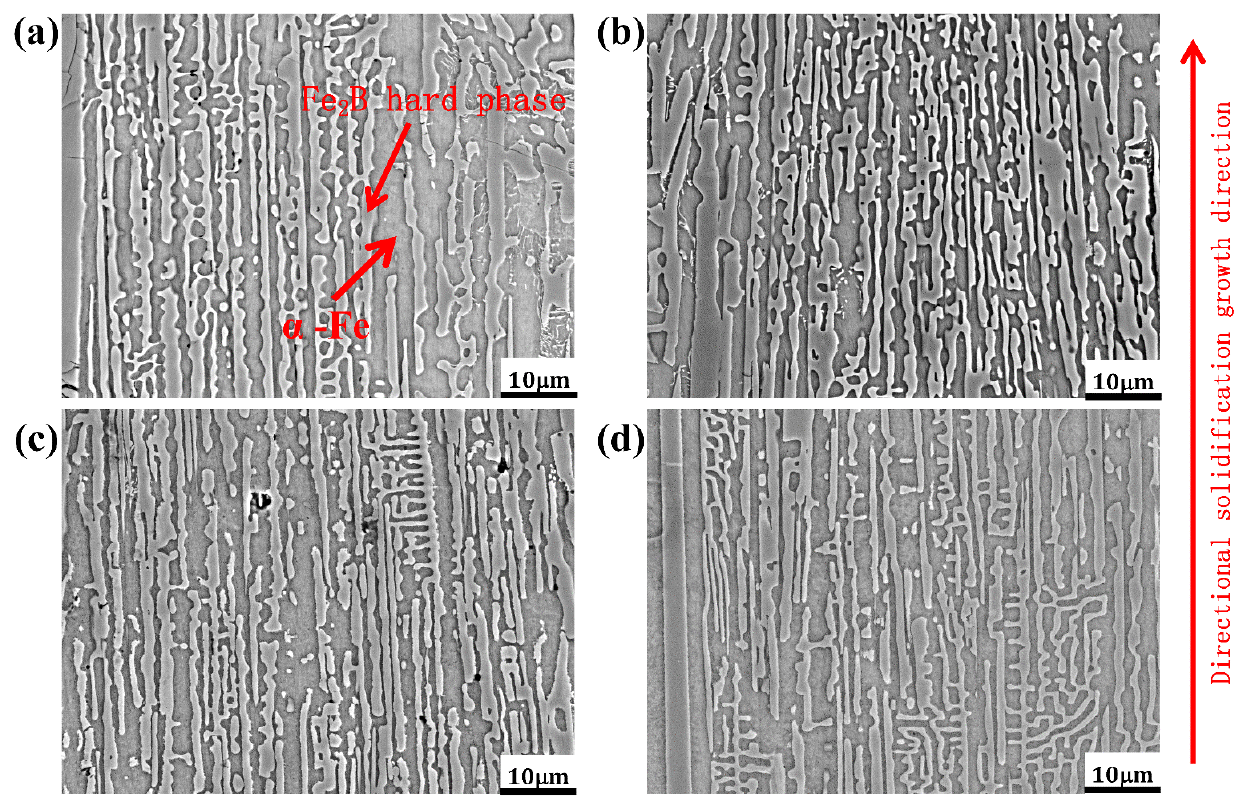
Figure 2. SE morphologies of as-cast DS Fe-B alloy: ( a ) A1, ( b ) A2, ( c ) A3, ( d ) A4.